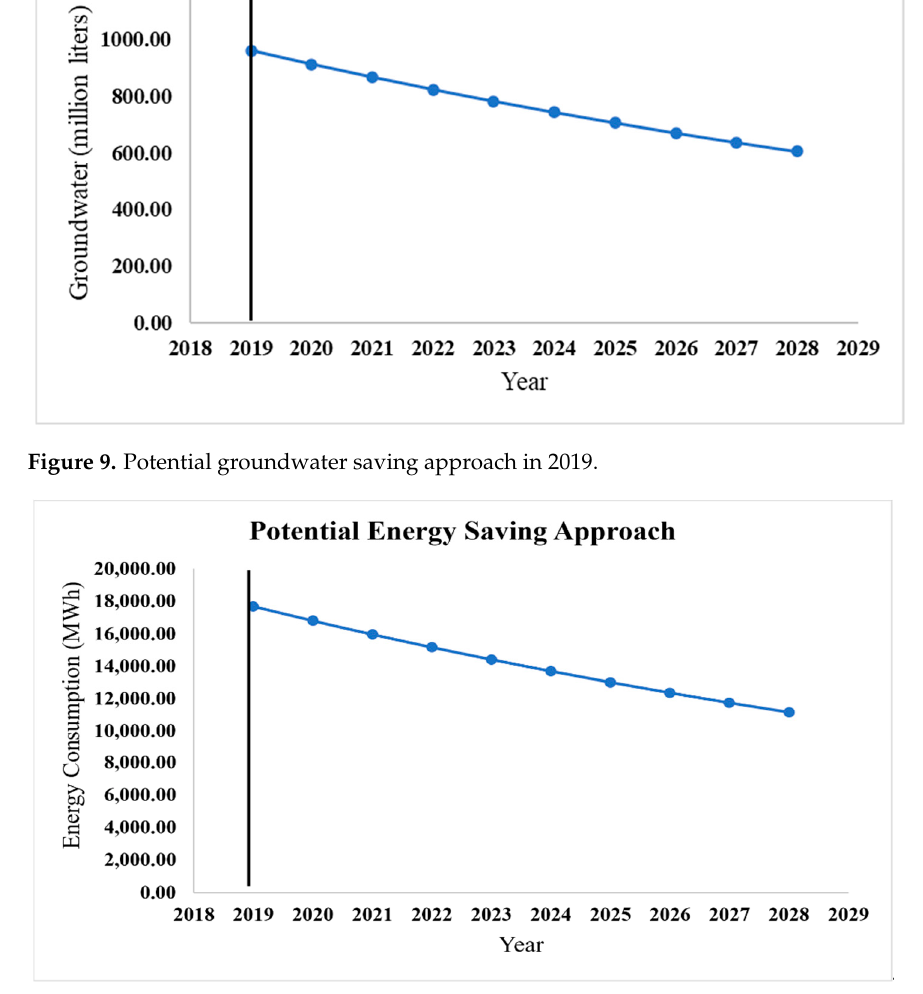
Figure 10. Potential energy saving approach in 2019.